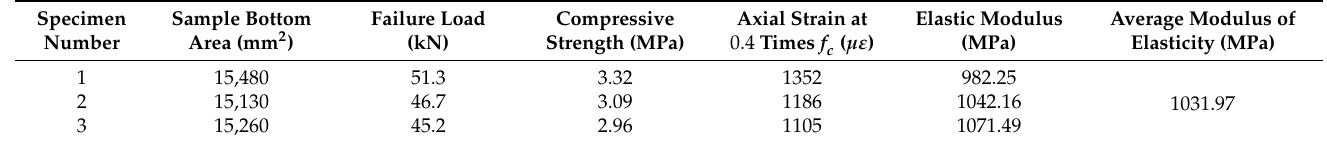
Table 3. Test data of masonry specimens.